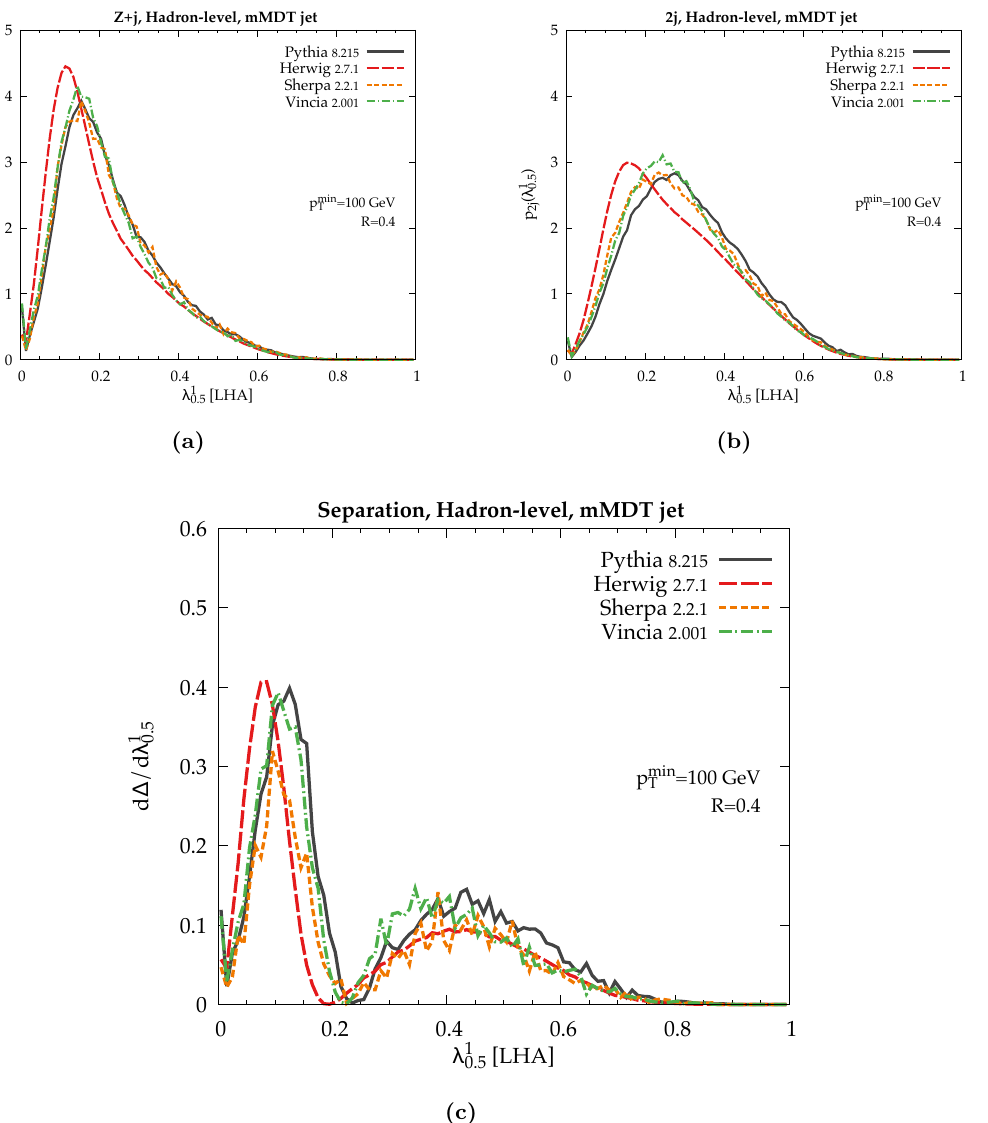
Figure 18. Same as (cid:12)gure 17 but after mMDT jet grooming with (cid:22) = 1 and z